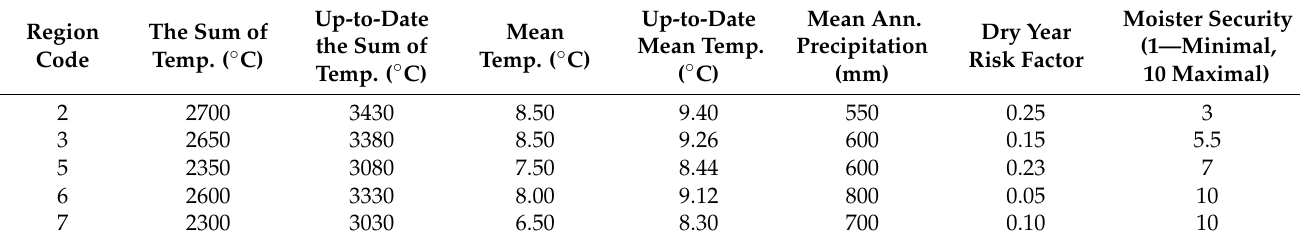
Table 1. The basic characteristics of the climate regions in the Czech